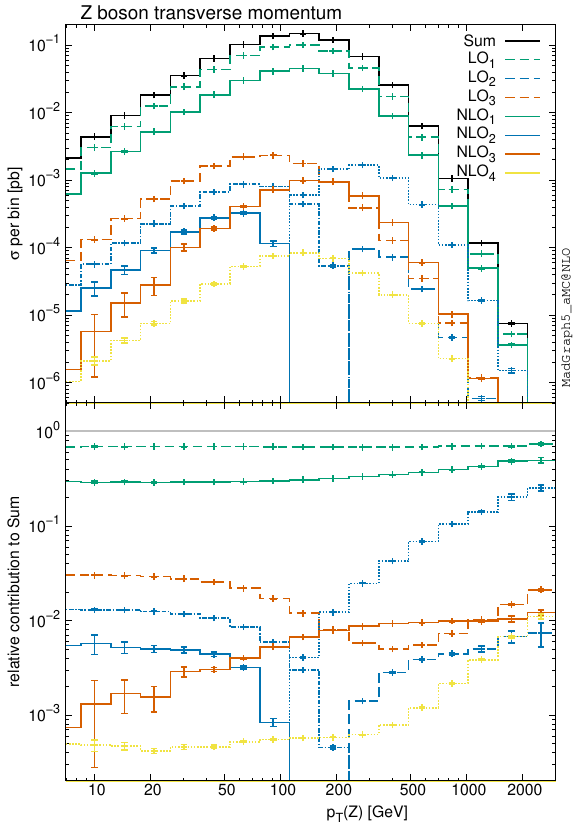
Figure 11. Transverse momentum of the Z boson in pp ! t (cid:22) tZ